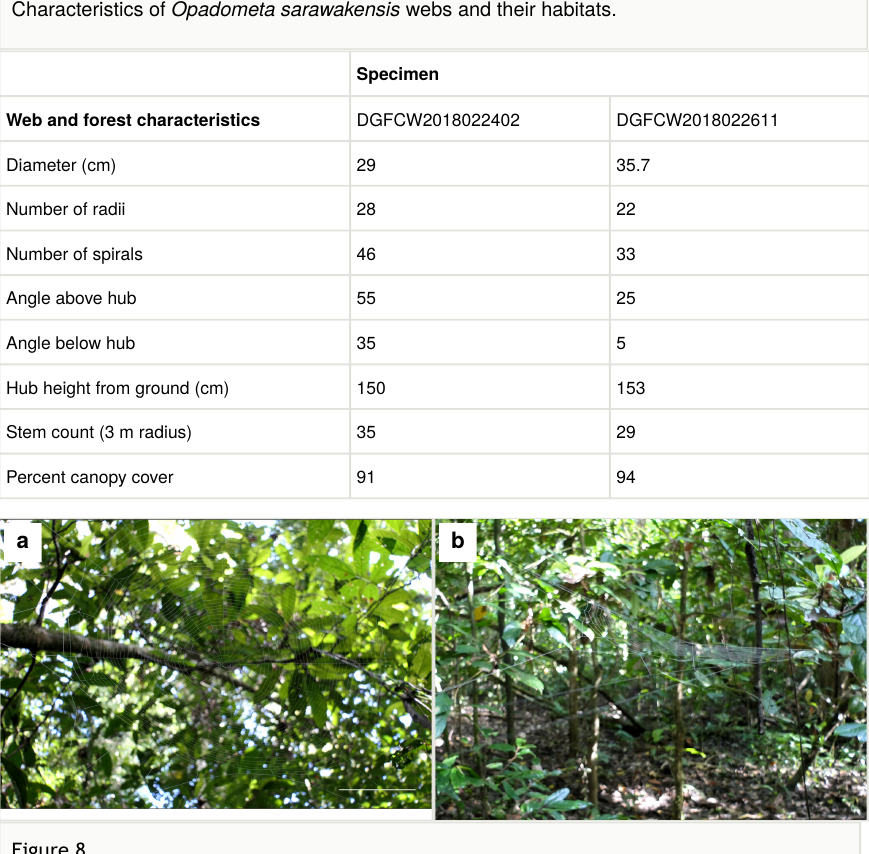
Characteristics of Opadometa sarawakensis webs and their habitats.